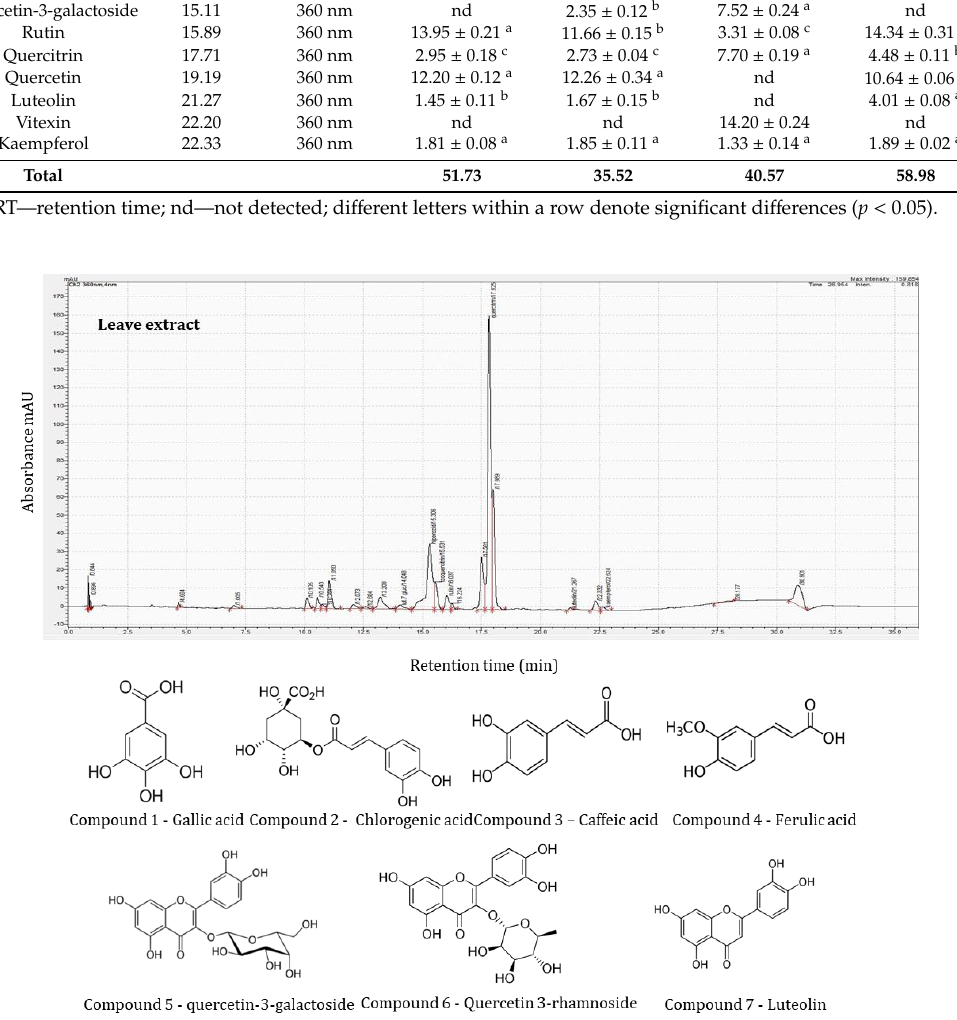
Figure 1. HPLC profile of sea buckthorn leaves extracts.